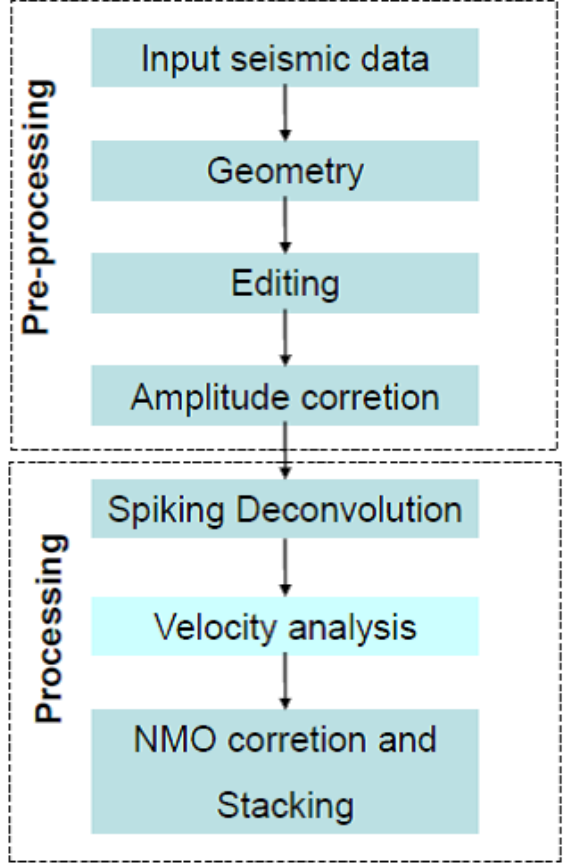
Figure 5. Processing flowchart of the marine seismic line 0214-0270 in the Jequitinhonha